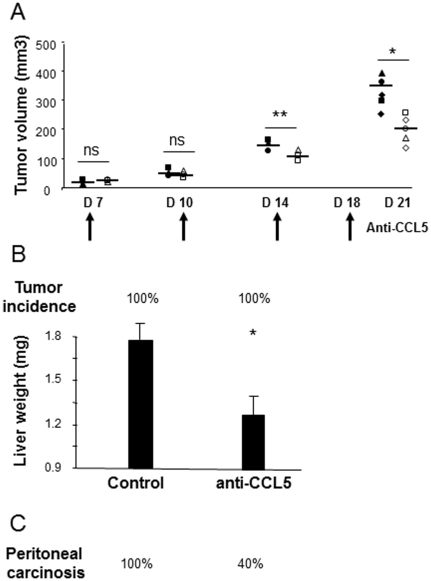
Protective effect of CCL5 neutralization on the development of colorectal tumors, metastases and peritoneal carcinosis.(A) Mice subcutaneously-challenged with CT26 cells received four intratumor injections of anti-CCL5 (open dots) or isotype-matched antibodies (filled dots) at the indicated times. Upon sacrifice, the extent of tumor development was assessed by measuring the tumor burdens. (B) Incidence and extent of tumor development within livers of CT26-challenged mice treated with anti-CCL5- or isotype-matched antibodies. (C) Incidence of peritoneal carcinosis expressed as percent of mice bearing carcinosis. (n = 5/group). * p<0.05, ** p<0.01.